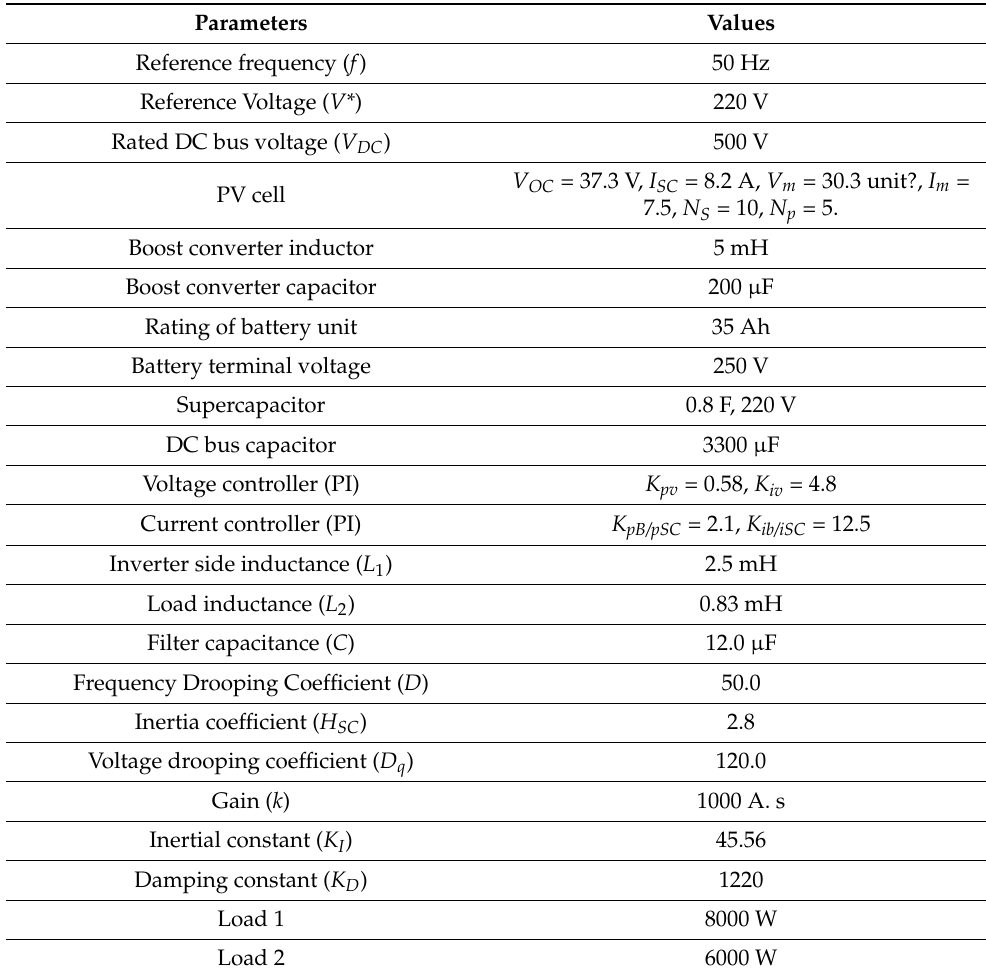
Table 1. Simulation and real-time simulation parameters.